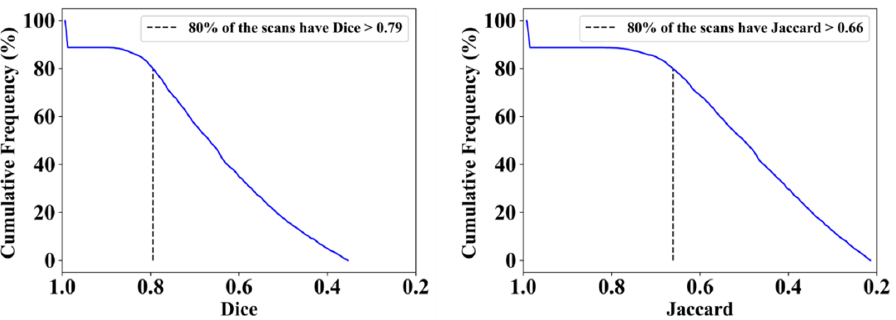
Figure 13. Cumulative frequency plot for Dice ( left ) and Jaccard ( right ) for VGG-SegNet when computed against MD 1.